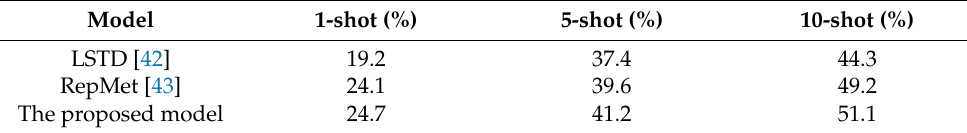
Table 2. mAP results of 50-way few-shot detection on 50 ImageNet categories.